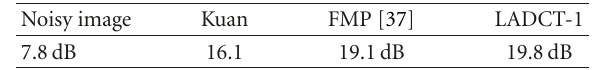
Table 3: SNR results for Lenna, degraded with 16-looks speckle